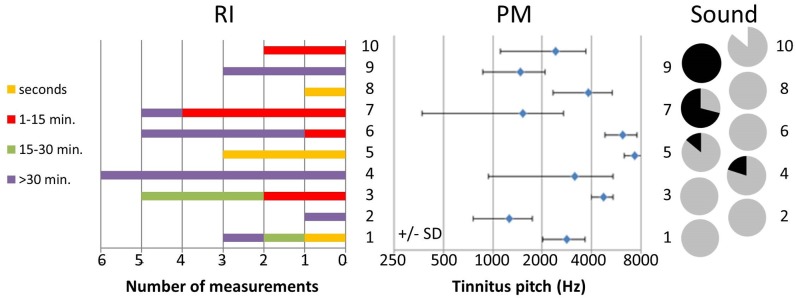
Subject-specific Residual Inhibition (left graph), tinnitus pitch (middle graph) and type of tinnitus perception (right graph) during the crossover design and the three-month follow-up period during modality-use of patient’s choice.The Y-axis represents the individual subjects. The percentages of the types of tinnitus perceptions were color-coded in the individual pie charts; black for pure tones, grey of narrow band noises and white for white noise.